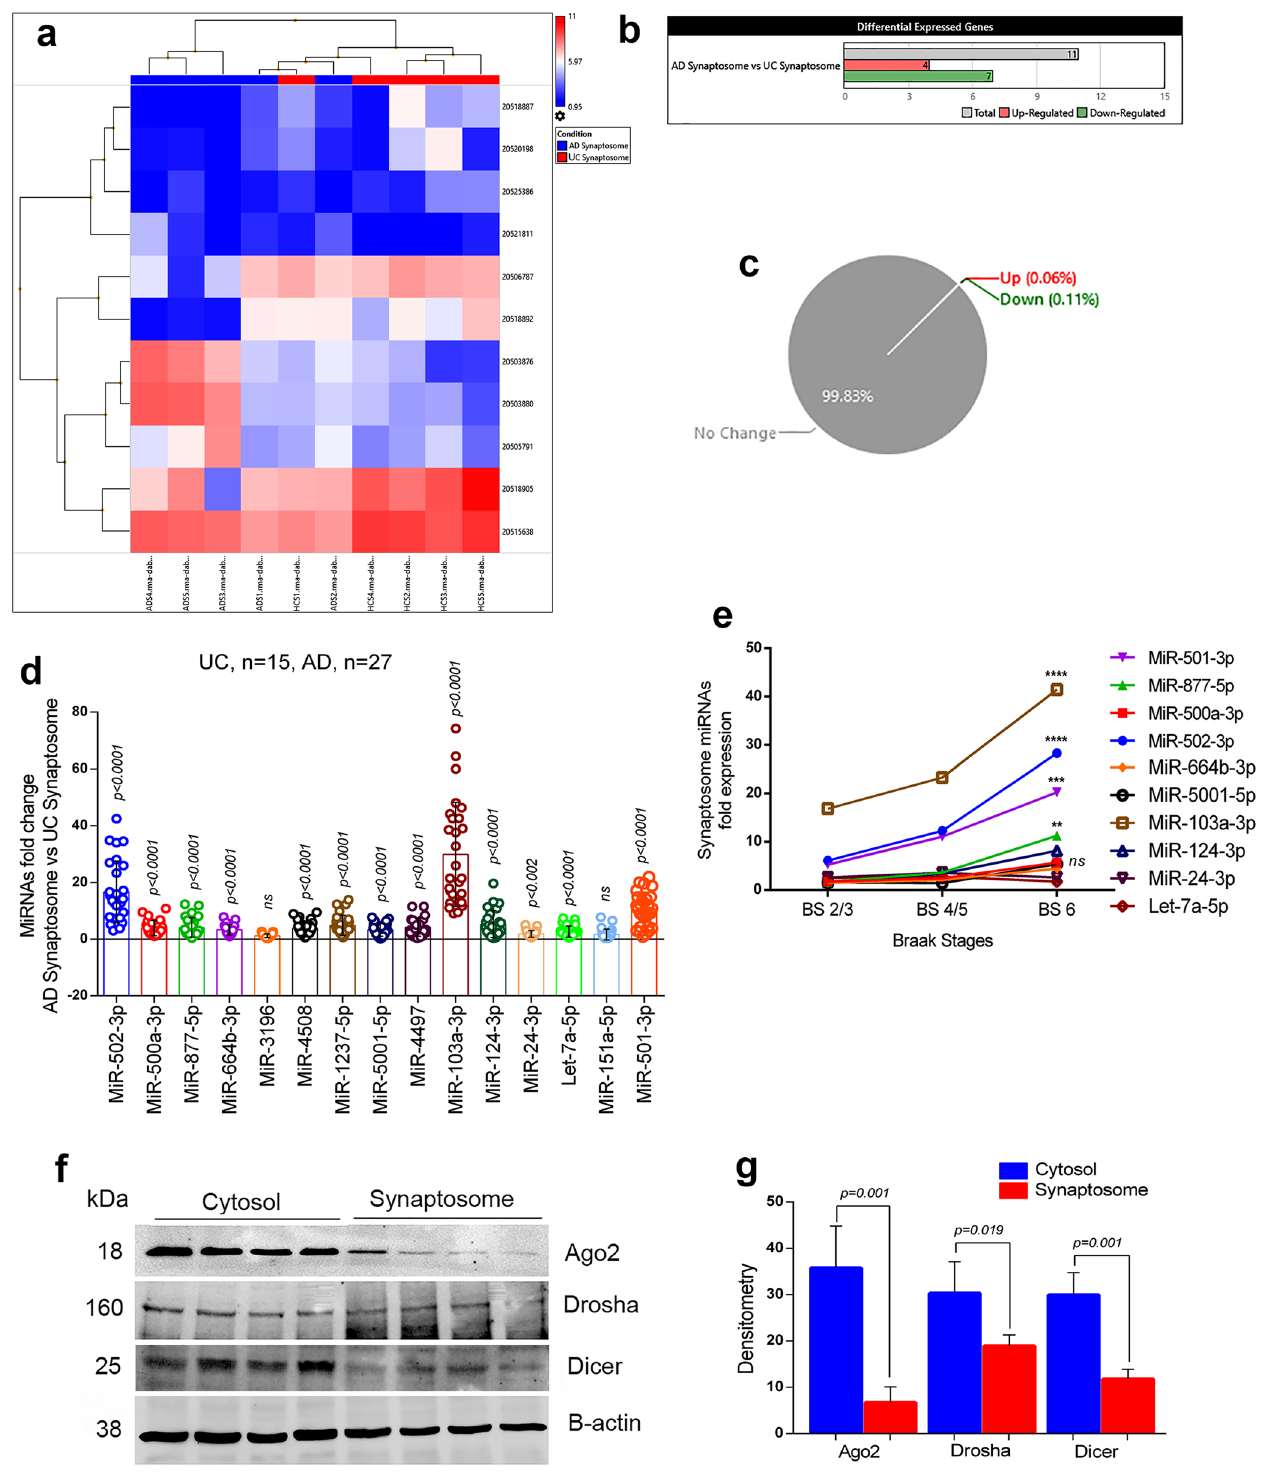
brain samples. The 13 miRNAs candidates were selected for validation analysis. Opposed to the Affymetrix data, nine miRNAs were signi fi cantly upregulated in AD cytosol relative to UC cytosol and three miRNAs did not show signi fi cant changes (Supplementary Fig. 4d). Again, the differences in the validation data could be due to sample-to-sample pathological and genetic